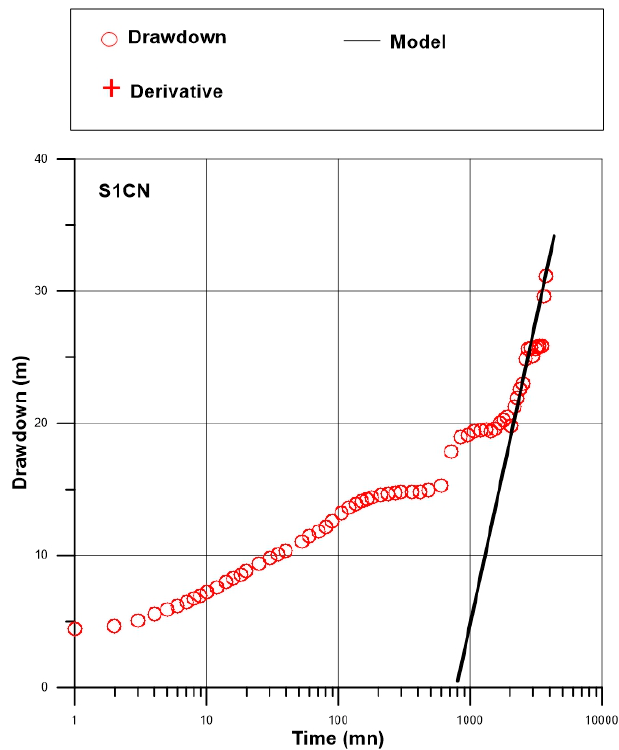
Figure 8. Semi-logarithmic plot of pumping data form pumping well S1CN and straight-line interpretation of late time data.